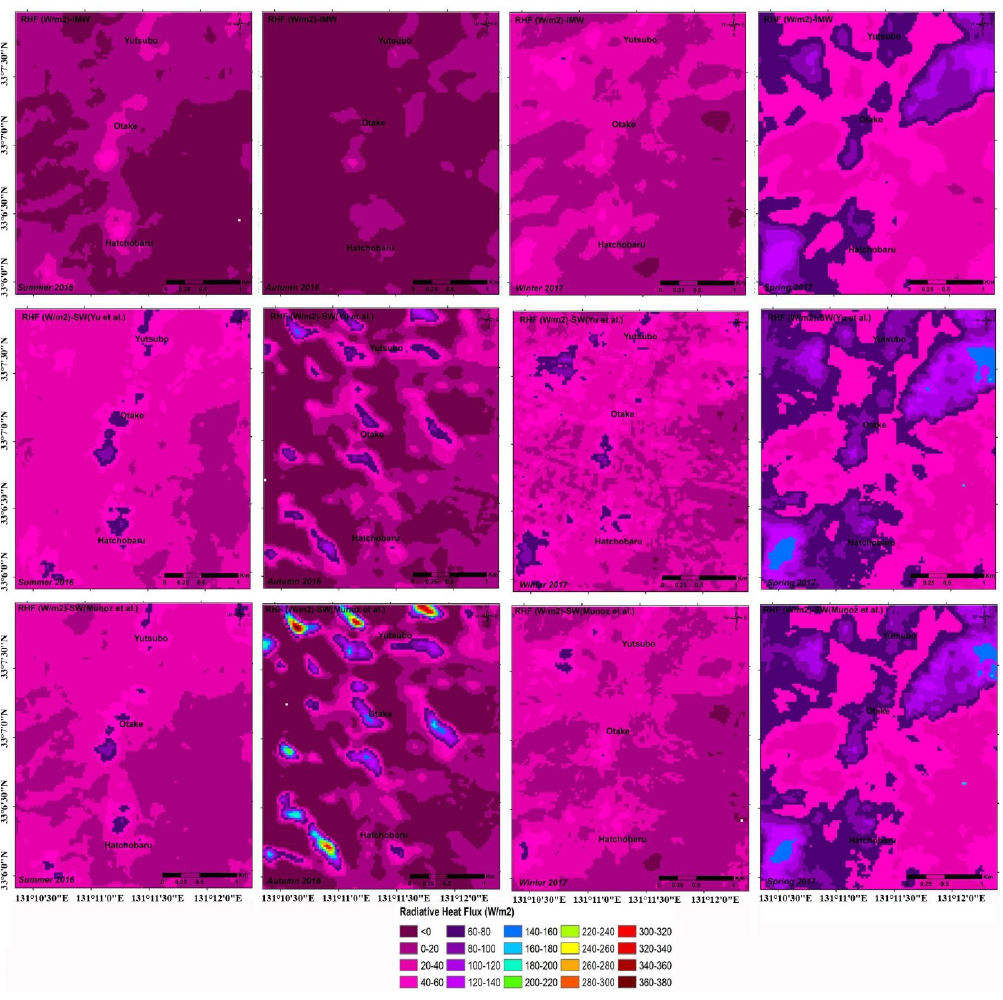
Figure 17. Seasonal radiative heat flux (RHF) within the study area for the daytime Landsat 8 thermal infrared data. The RHFs for each season processed using the improved mono-window (IMW) algorithm are shown in the top row; the RHFs for each season processed using the split-window (SW) algorithm of Yu et al. [19] are shown in the middle row; while the RHFs for each season processed using the SW algorithm of Jiménez-Muñoz et al. [20] are shown in the bottom row. The seasons are arranged in the order of summer, autumn, winter, and spring, in all of the rows.